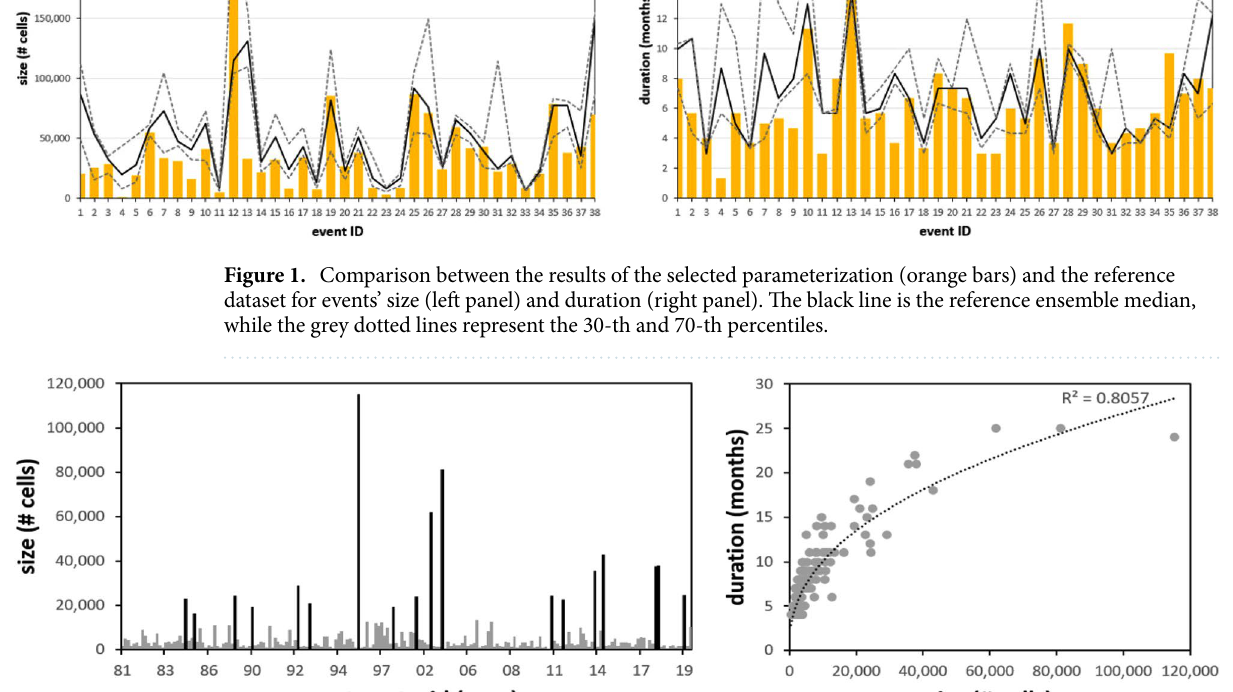
Figure 2. Summary of the outputs of the clustering analysis. The left panel shows the temporal distribution of the events, with the black bars highlighting the major droughts (size > 15,000 cells). The right panel shows the relationship between the size and the duration of the events, with the dotted line representing a power